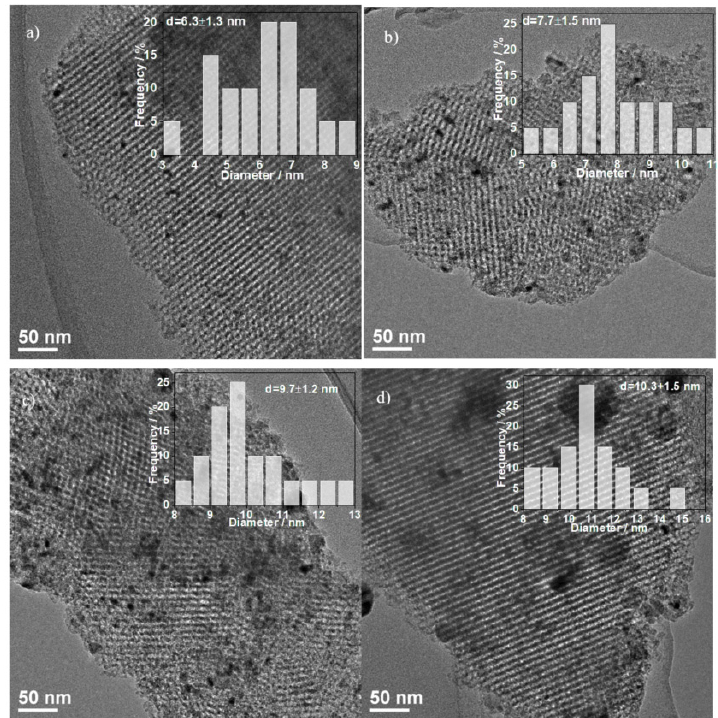
Figure 6. TEM patterns of the studied catalysts: ( a ) 400, ( b ) 450, ( c ) 500, and ( d ) 550.